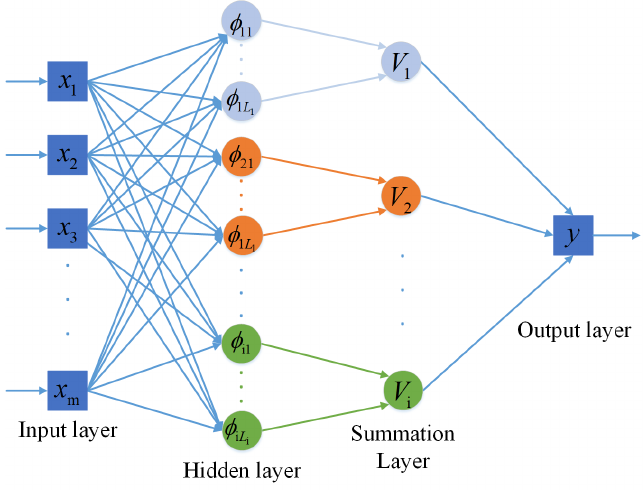
Figure 5. Structure of the PNN